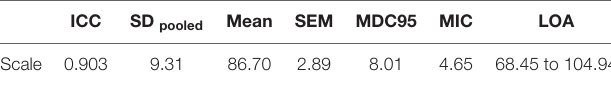
TABLE 6 | The results of stability, SEM, responsiveness, and